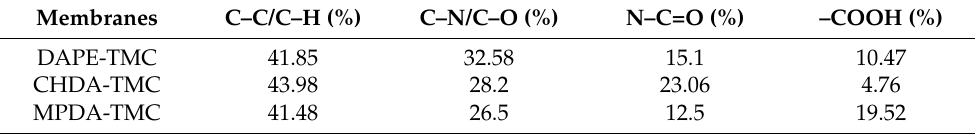
Table 1. Chemical functional groups on the surface of TFC membranes, as identified from XPS